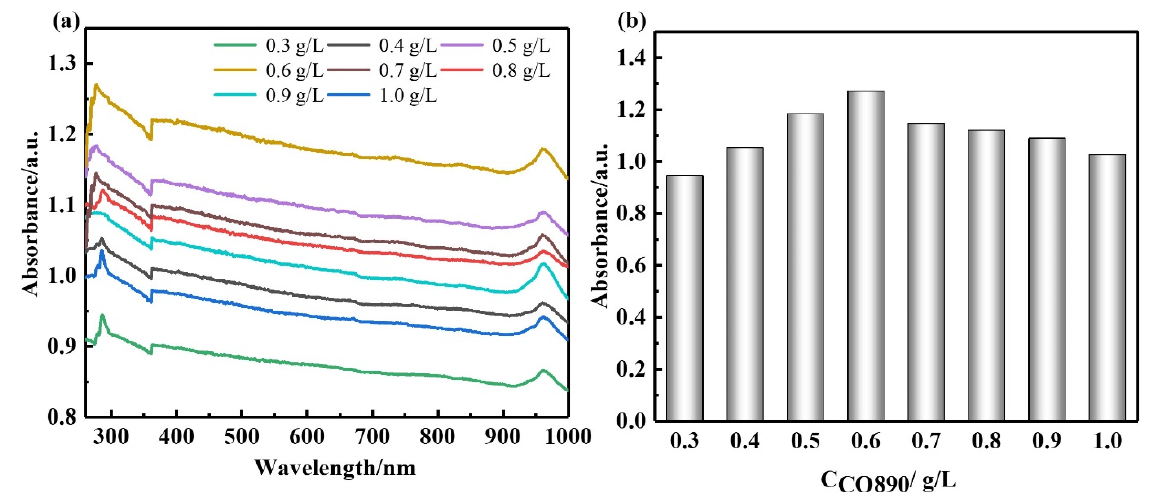
Figure 3. The dispersion of GNPs: ( a ) UV ‐ VIS of GNPs dispersions; ( b ) absorbance of GNP dispersions.